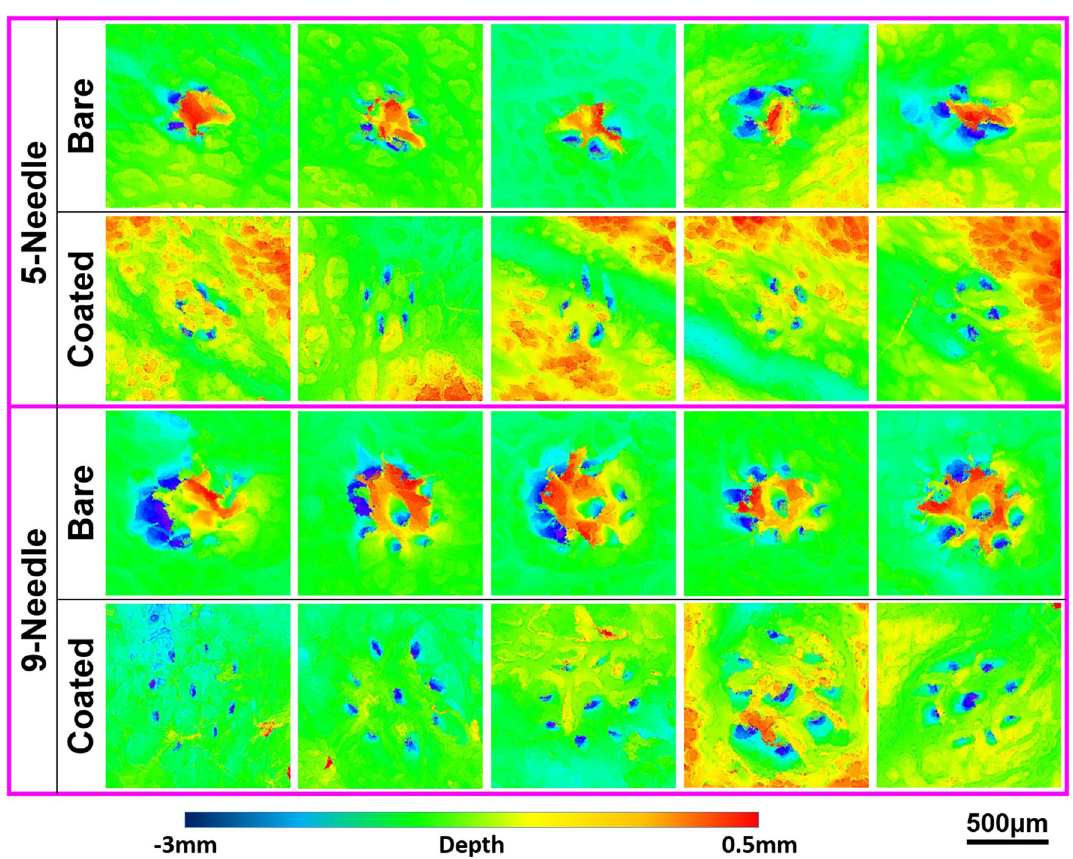
Figure 2. Confocal microscope images of pork skins following one-time insertion tests with bare and coated 5- and 9-needles. The images reveal the skin surface height from high to low by the red to blue color gradient,